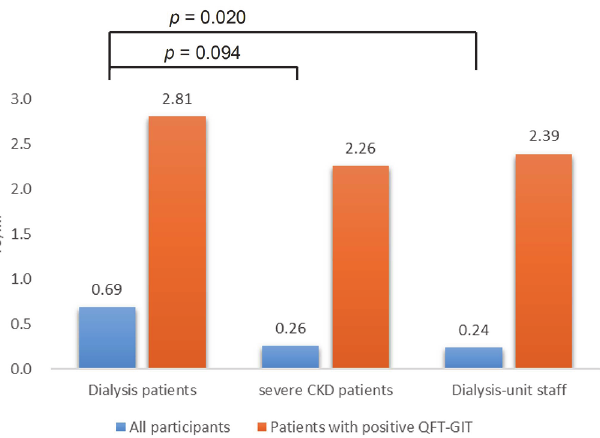
Fig 2. The response of QuantiFERON-TB Gold In-tube (QFT-GIT), calculated by the interferon- γ level in TB-antigen tube minus that in the negative control, are shown in all and those with positive QFT-GIT according to the different